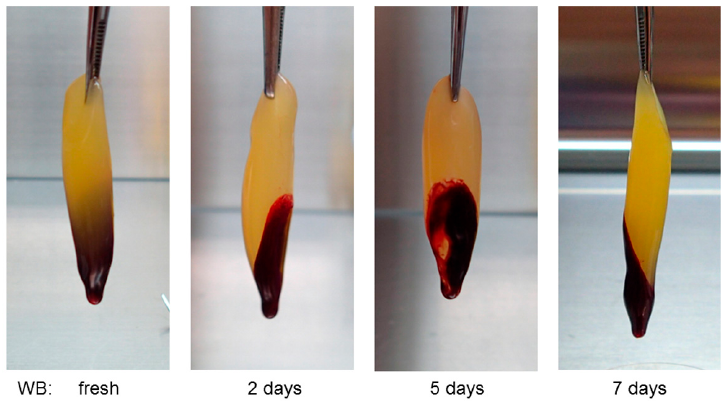
Figure 5. Visual appearance of platelet-rich fibrin–like matrixs (PRFMs) prepared from WB samples stored for the indicated periods. WB samples were simultaneously collected from the same donor. Similar PRFM samples were obtained from three other experiments.